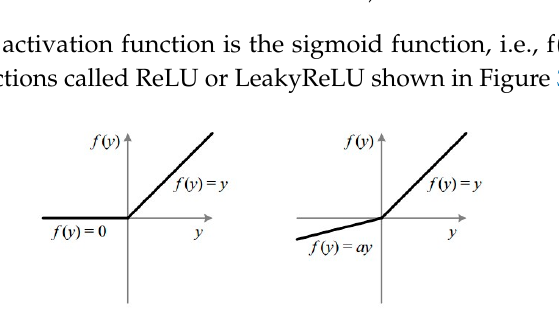
Figure 3. State-of-the-art activation functions. ( a ) ReLU activation function; ( b ) LeakyReLU activation functions .